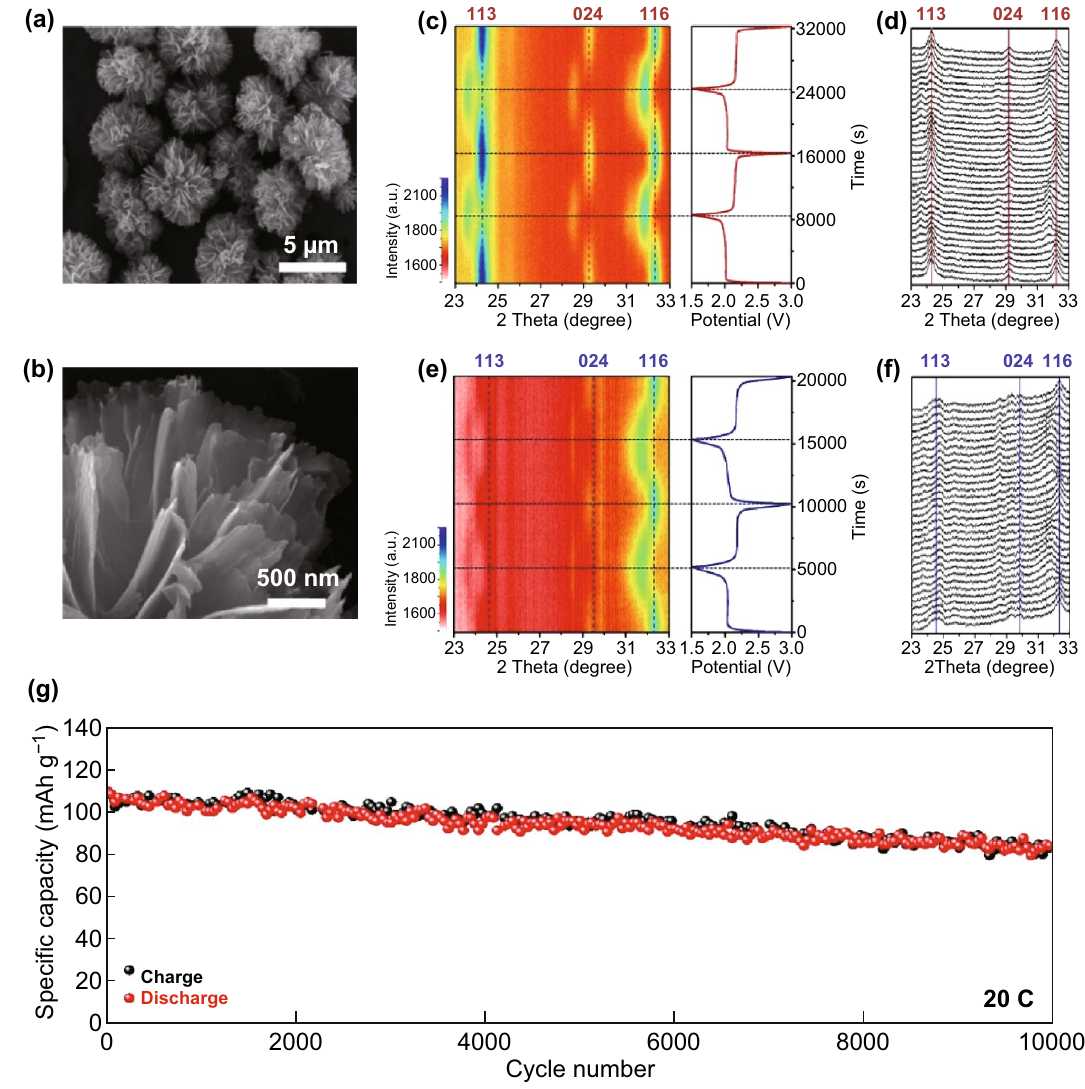
Fig. 4 a , b Field emission SEM images of carbon-coated hierarchical NaTi 2 (PO 4 ) 3 mesoporous microflowers (NTP/C-F), and in situ XRD pat- terns of the carbon-coated NTP particles (NTP/C-F and NTP/C-P)) half-cells during galvanostatic discharge and charge at 50 mA g −1 and a voltage range of 1.5–3.0 V. c image plot of diffraction patterns and d selected individual diffraction patterns of the NTP/C-F stacked against the voltage profile at 23–33° during the first two discharge–charge cycles. e Image plot of diffraction patterns and f selected individual diffraction patterns of the NTP/C-P stacked against the voltage profile at 23–33° during the first two discharge–charge cycles. g Ultralong cycling stability of the NTP/C-F for 10,000 cycles at 20 C [41]. Copyright 2016, Elsevier